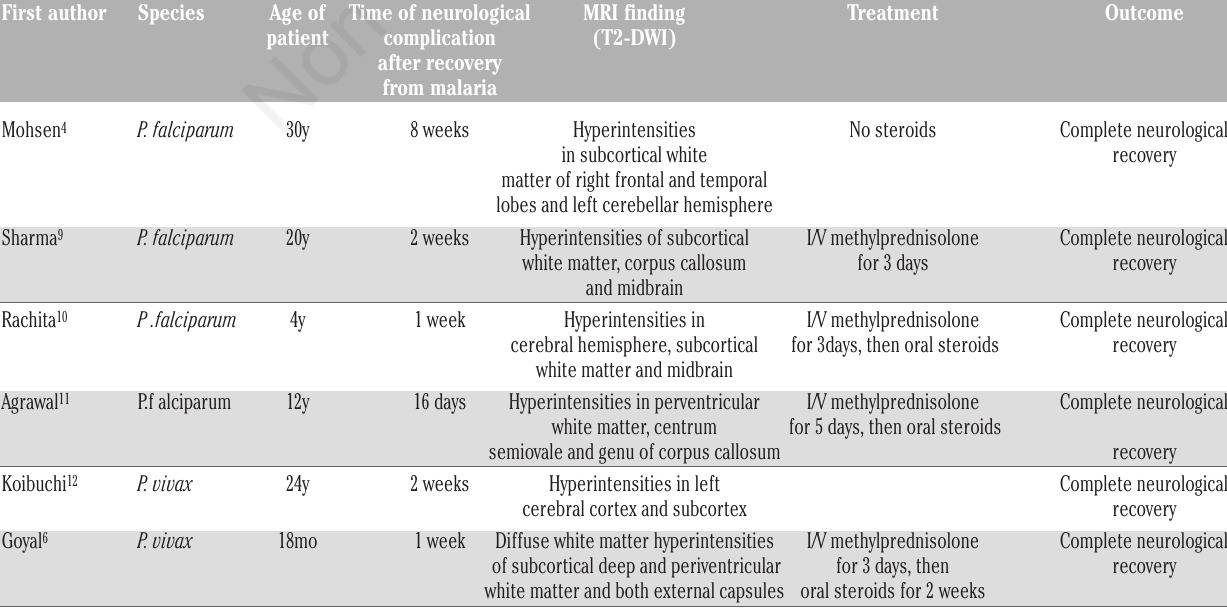
Table 1. List of cases of acute demyelinating encephalomyelitis reported after recovery from malaria.